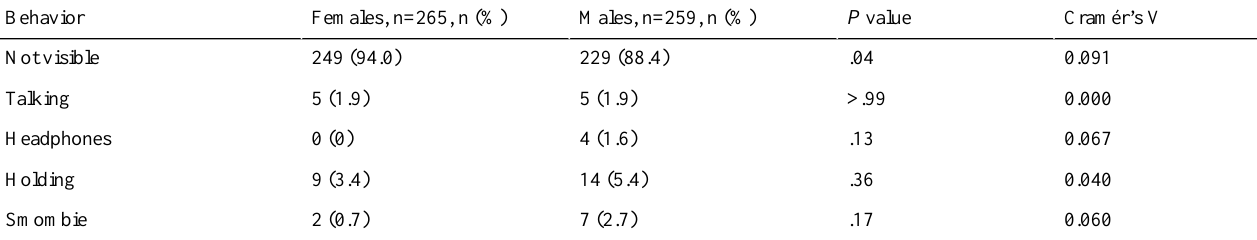
Table 8. Influence of gender on smartphone usage behavior in older people (n=524, globally P =.07, V=0.13).